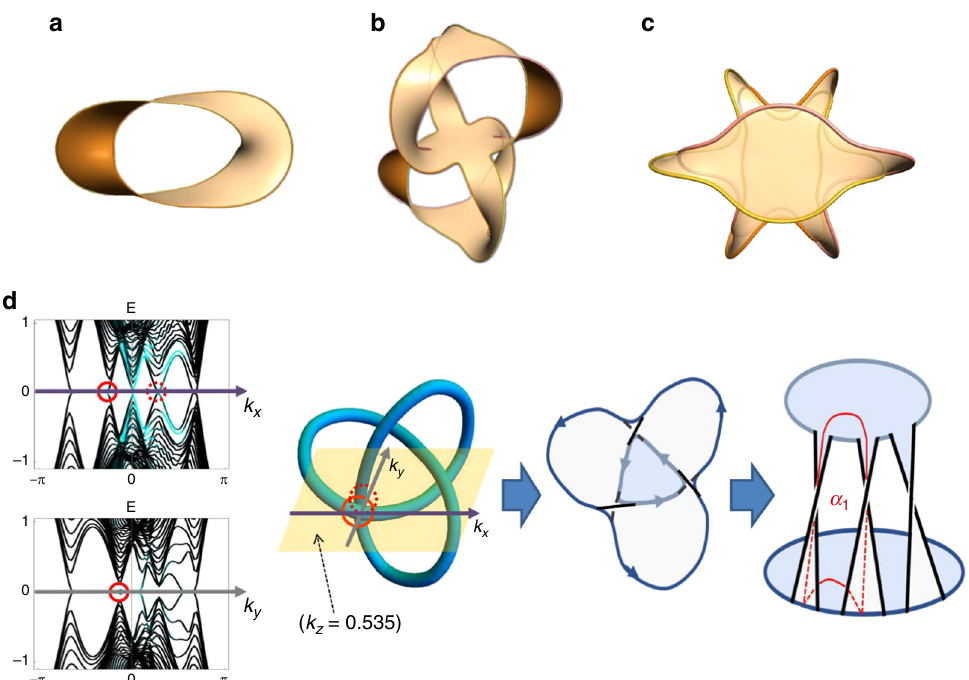
, b Borromean rings 1